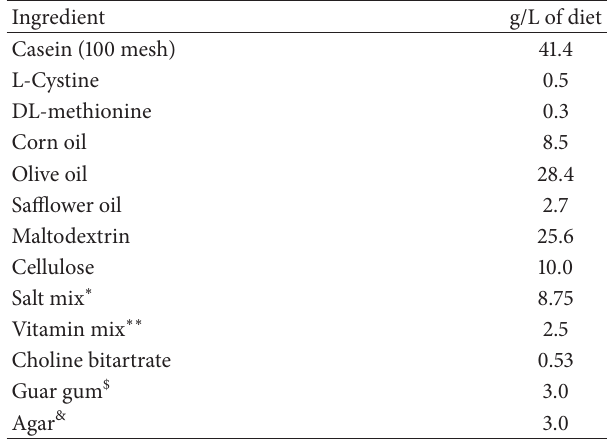
Table 1: High fat diet